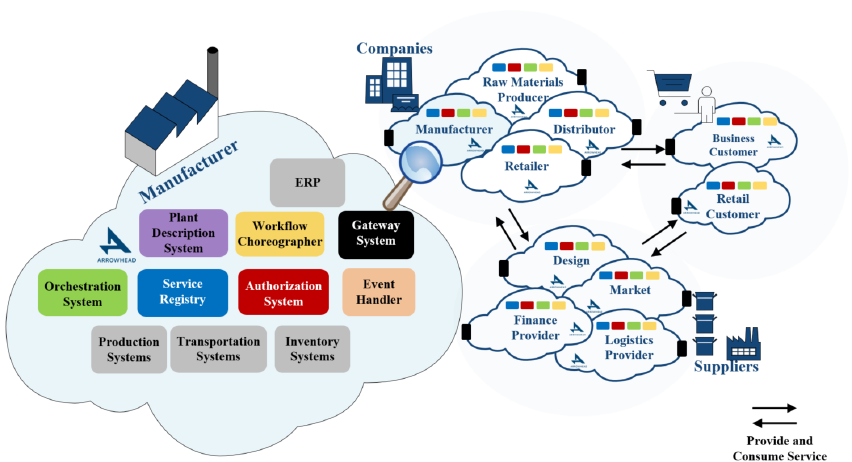
Figure 4. System-of-Systems established throughout the supply chain network can exchange information in a service oriented architecture.[7]